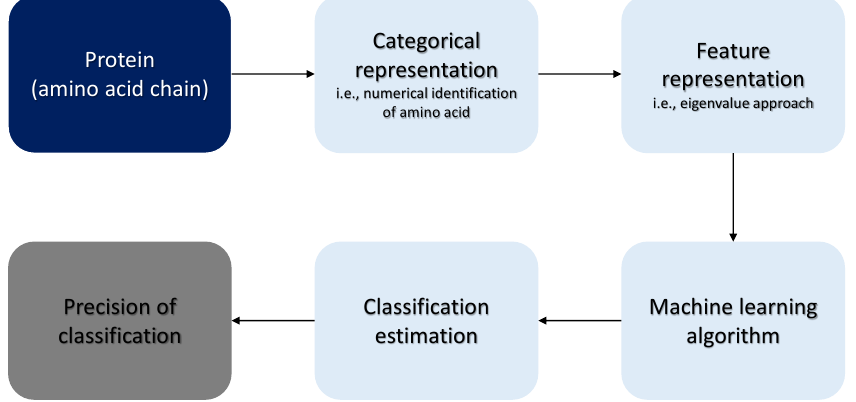
Figure 1. Simplified flowchart